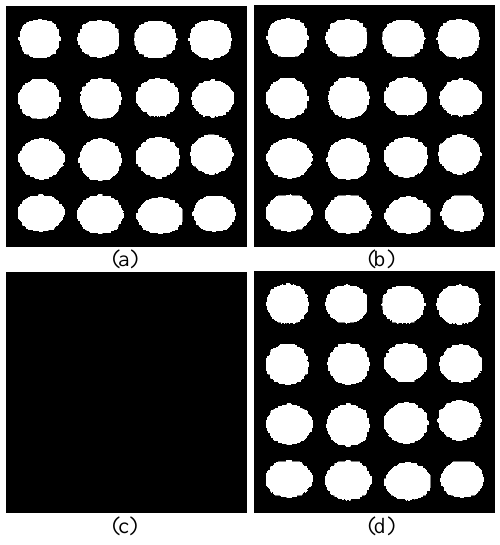
Fig. 6. Result of circle: (a) Good circle(ITT2); (b) Good circle(ITC); (c) Bad circle(ITT2); (d) Bad circle(ITC)